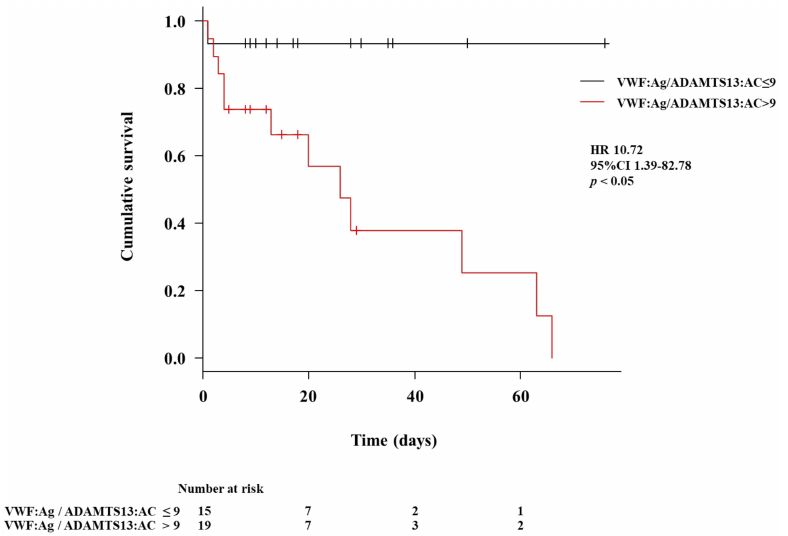
Figure 5. Cumulative survival according to the VWF:Ag/ADAMTS13:AC in patients with liver cir- rhosis in the post-ACLF group. The patients with LC in the post-ACLF group were categorized